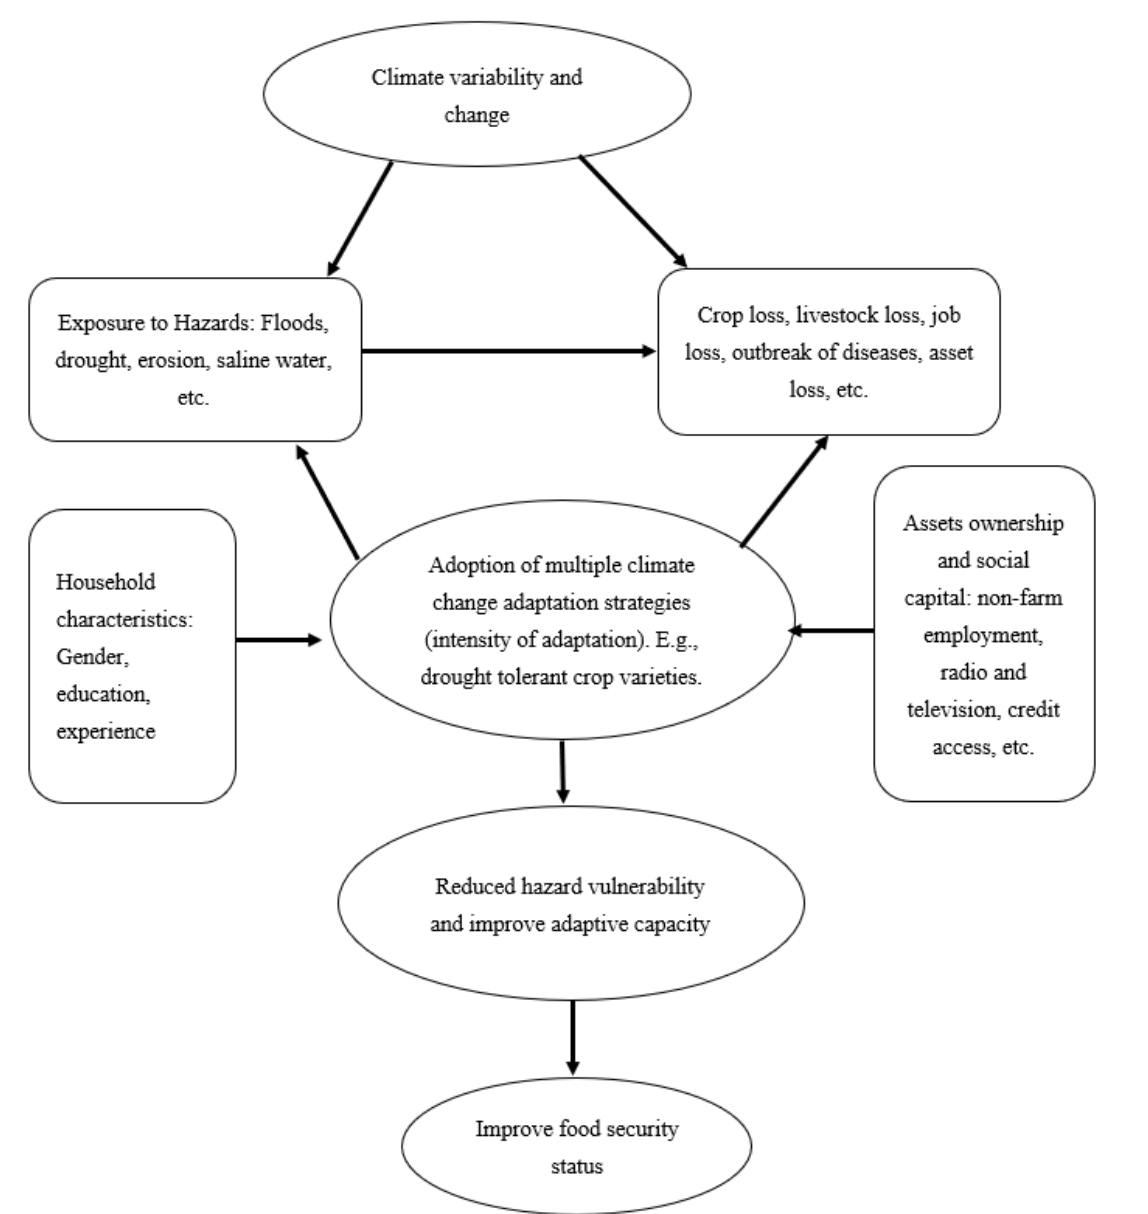
Figure 1. Conceptual framework showing climate change, exposure to hazards, adoption of climate change adaptation strategies, and households’ food security status. The arrows indicate the expected direction of effect on the corresponding variables.